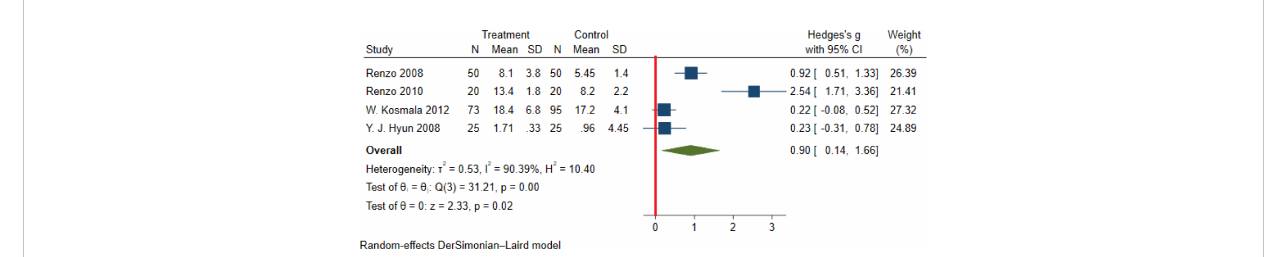
FIGURE 3 The extracted and overall association between NWO and IL 6. (The red line represents null